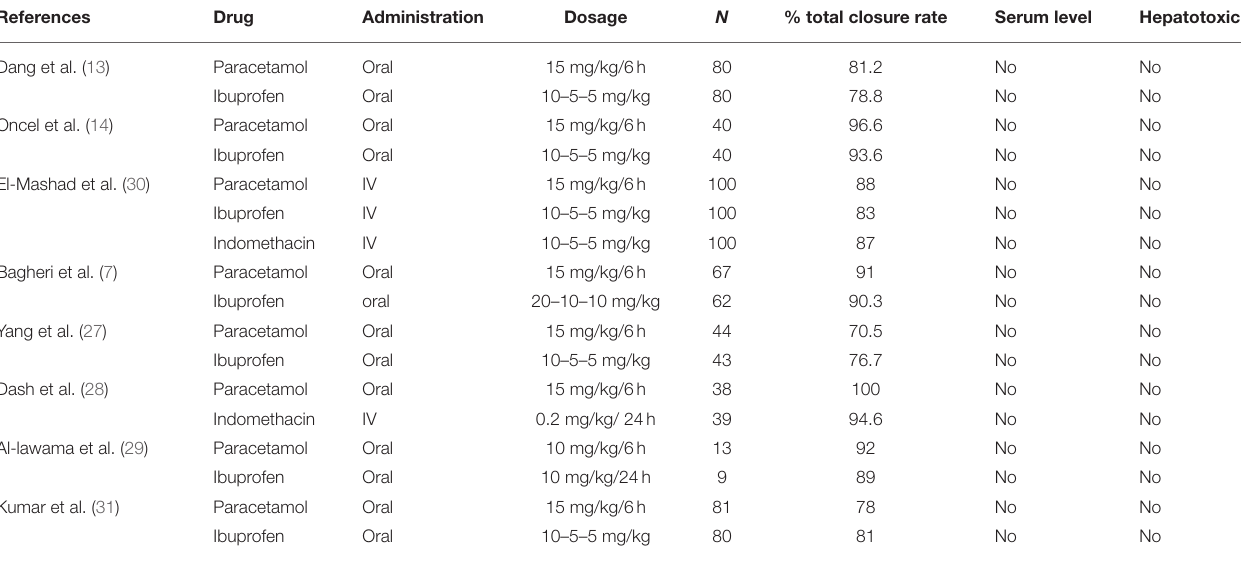
TABLE 1 | Randomized clinical trial: paracetamol vs. active drug (ibuprofen or